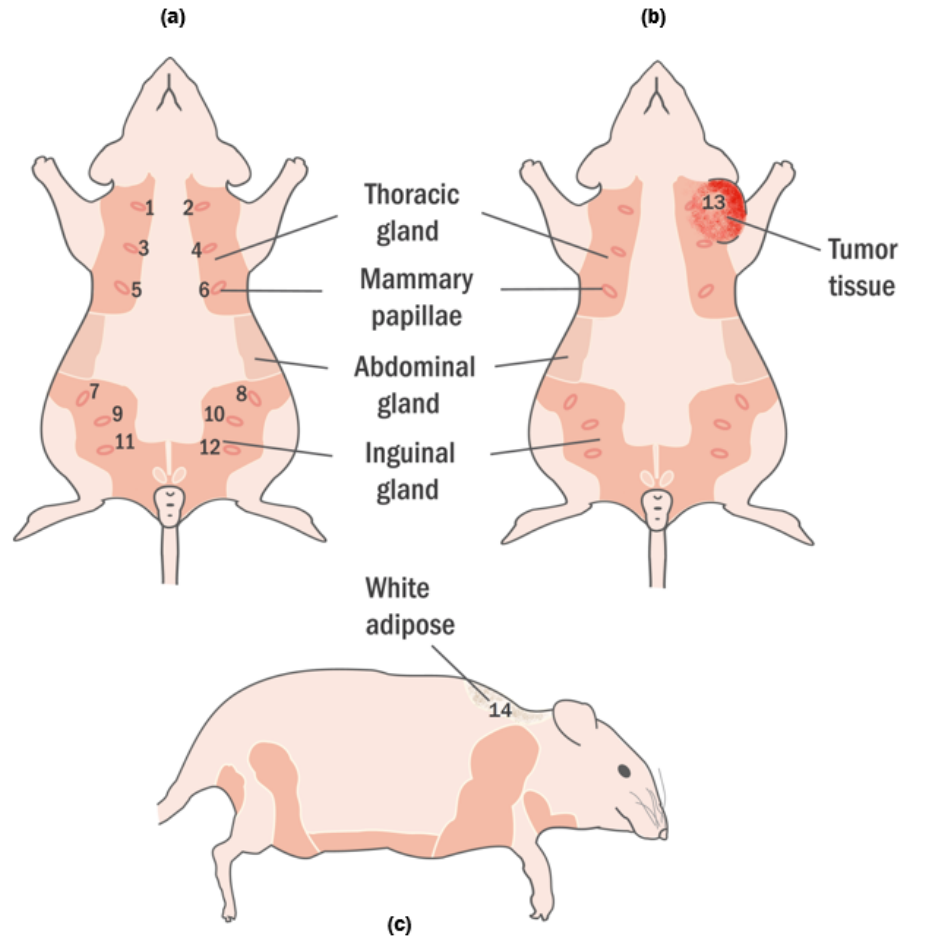
Figure 1. Healthy and tumor-bearing rats have been demonstrated. ( a ) Healthy rats are shown in the frontal plane with marked 12 nipples. The locations of the nipples are in the region of thoracic and inguinal. ( b ) The rat with tumor is shown in the frontal plane and tumor was marked with 13. The tumor according to the mammary tissues was formed around the 2nd and 4th tissue. ( c ) The healthy rat was shown in the sagittal plane. The white adipose, located on the nape, is marked